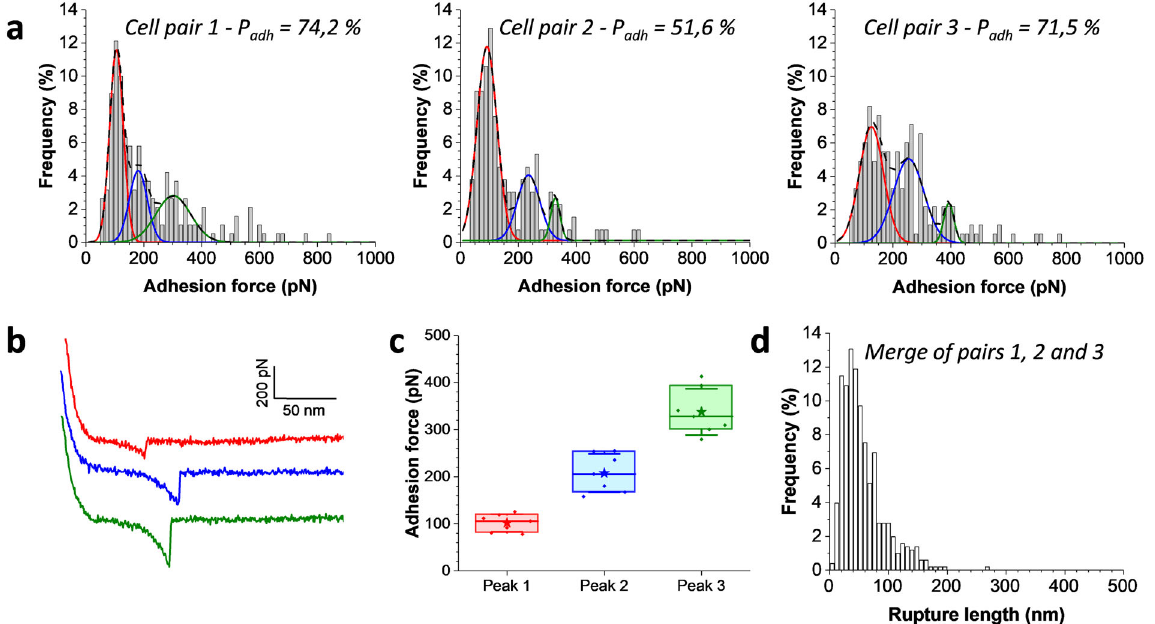
Fig. 2 The binding strength of single agglutinins. a Maximum adhesion force histograms obtained by recording force – distance curves in PBS between three independent MAT a and MAT α cell pairs pretreated with pheromones, at an applied force of 1 nN, with a probing time of 1 s and a retraction velocity of 1000 nm s − 1 . The corresponding adhesion probability ( P adh ) is mentioned in each histogram. Gaussian fi ts for a multimodal distribution are overlapped with the raw histogram: in colored plain lines, the independent Gaussians and in dashed black lines the overall fi t. b Representative retraction force pro fi les color coded according to the peaks identi fi ed in the distributions. c Box plots of the mean adhesion forces revealed by the multi-peak center analysis, as illustrated in a . Stars are the mean values, lines the medians, boxes the 25 – 75% quartiles, and whiskers the SD from N = 7 independent cell pairs. d Rupture length histogram obtained by merging the data obtained on the three cell pairs shown in a